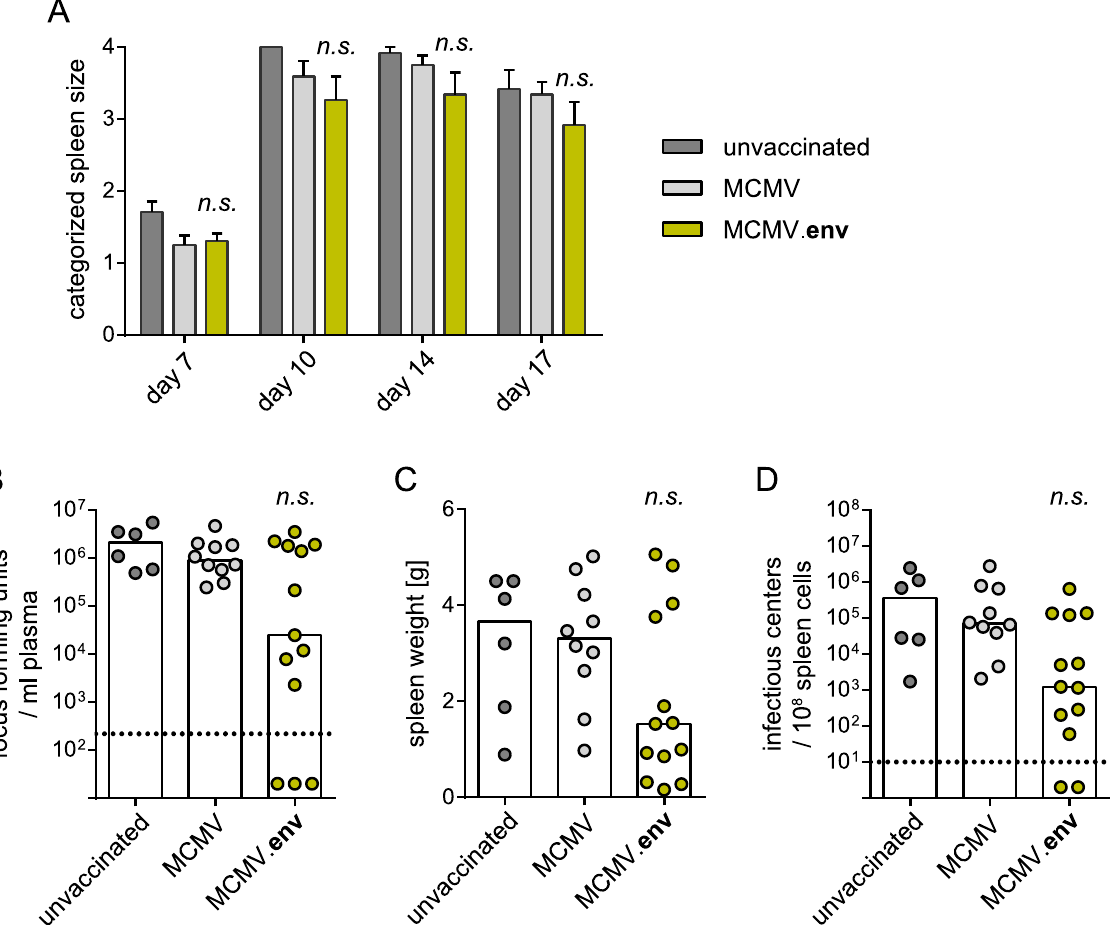
Fig 3. No protection from early FV challenge after MCMV.env immunization. CB6F1 mice were immunized once with MCMV.env, or a non-transgene-encoding control MCMV, and infected with 5 000 SFFU FV three weeks later. Development of splenomegaly was monitored by twice-weekly palpation of the spleens (A). Viremia levels were determined in blood samples collected 10 days after FV infection (B); spleens were isolated three weeks after FV infection and spleen weights (C) and spleen viral loads were analysed (D). Each dot indicates an individual mouse, columns indicate mean (A, C) or median values (B, D), column whiskers indicate the standard error of the means (A), dotted lines indicate the limits of detection. Data were obtained in three independent experiments, using 6 (unvaccinated), 10 (MCMV) or 13 mice (MCMV.env) per group. Data were analysed for statistically significant differences by One Way ANOVA on Ranks with the Dunn’s post test (n.s.: not significant).